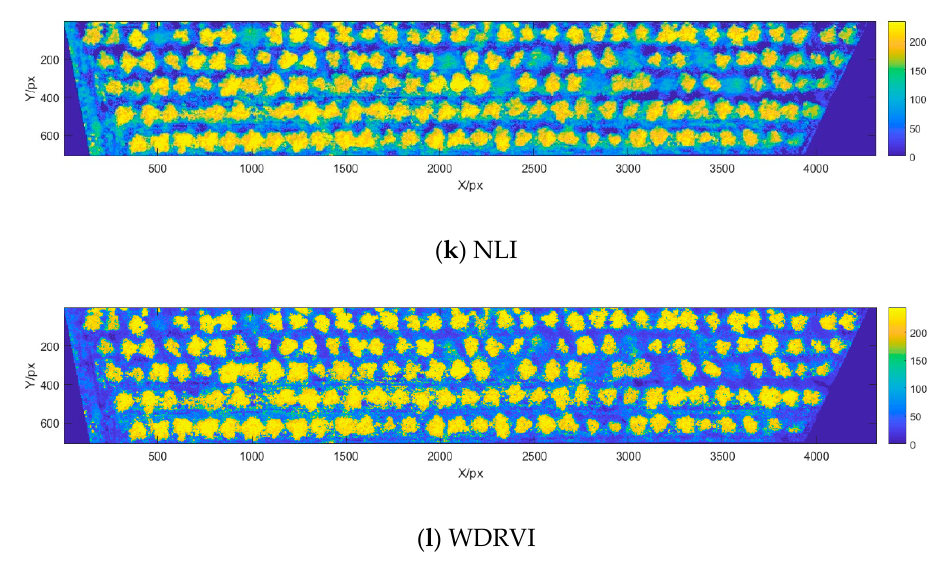
Figure 1. Three-dimensional point-cloud models and vegetation index images of the apple orchard. Table 3. Vegetation indices and their calculation formulas.